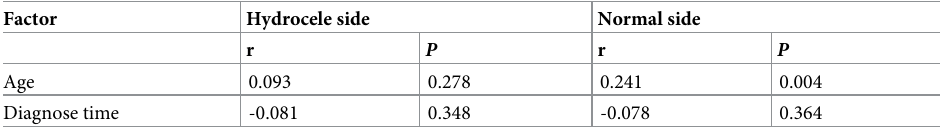
Table 2. Spearman’s rank correlation analysis with volume of the testis in 138 patients.